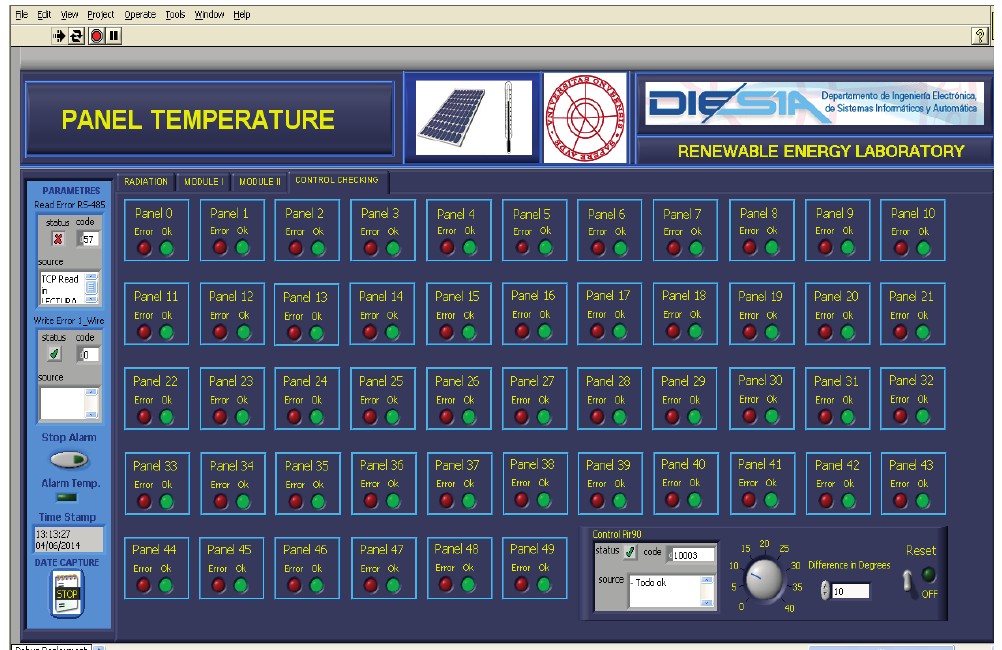
Figure 10. VI for the comparison of temperatures between adjacent panels.